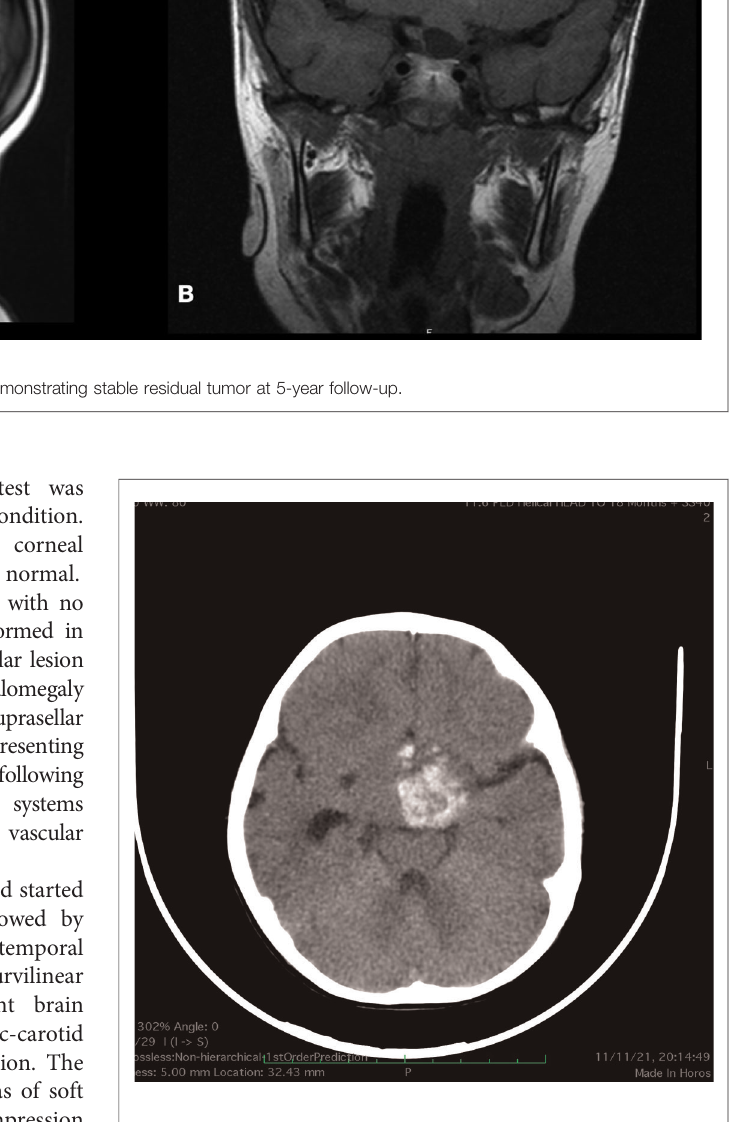
FIGURE 5 | CT scan of the brain (case 2) reveals a large hyperdense suprasellar lesion and mild ventricular